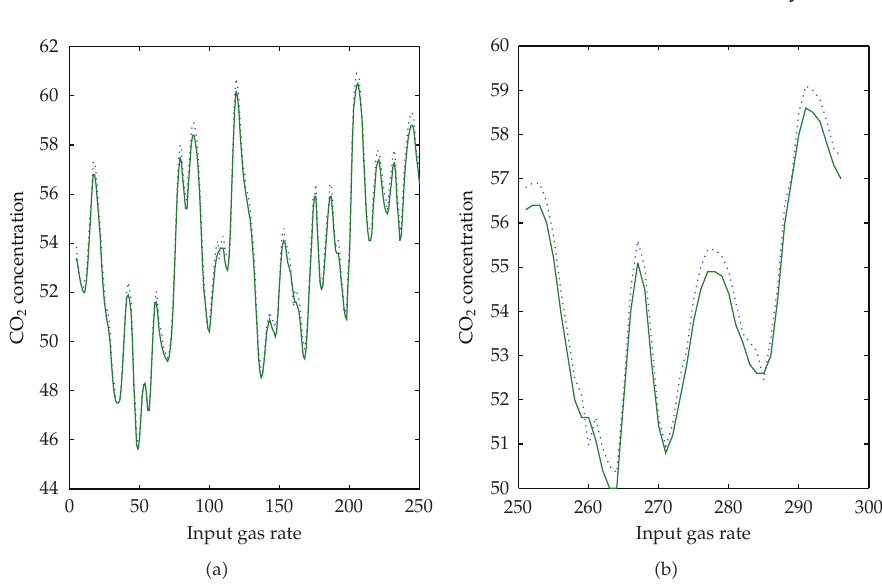
Figure 5: (cid:3) a (cid:4) Fitted values of O t (cid:3) t (cid:5) 5 ,..., 250 (cid:4) for gas data; (cid:3) b (cid:4) Predictive values O t (cid:3) t (cid:5) 251 ,..., 296 (cid:4) for gas data. Dotted lines are fitted or predicted; solid lines are